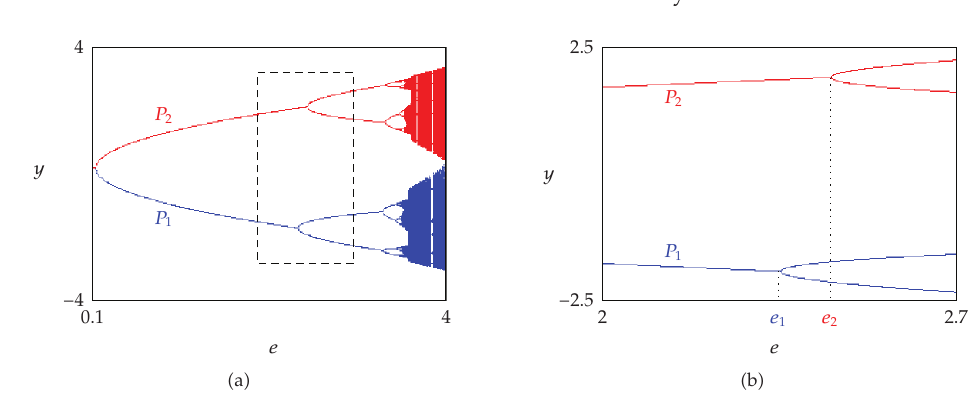
Figure 8: Bifurcation diagrams (cid:5) b.d. for short (cid:6) . In blue the b.d. corresponding to an initial condition close to P 1 , whereas the b.d. in red is obtained with an initial condition close to P 2 . Panel (cid:5) b (cid:6) is a magnification of a portion of the b.d. in (cid:5) a (cid:6) , which emphasizes the values of parameter e at which the steady states lose